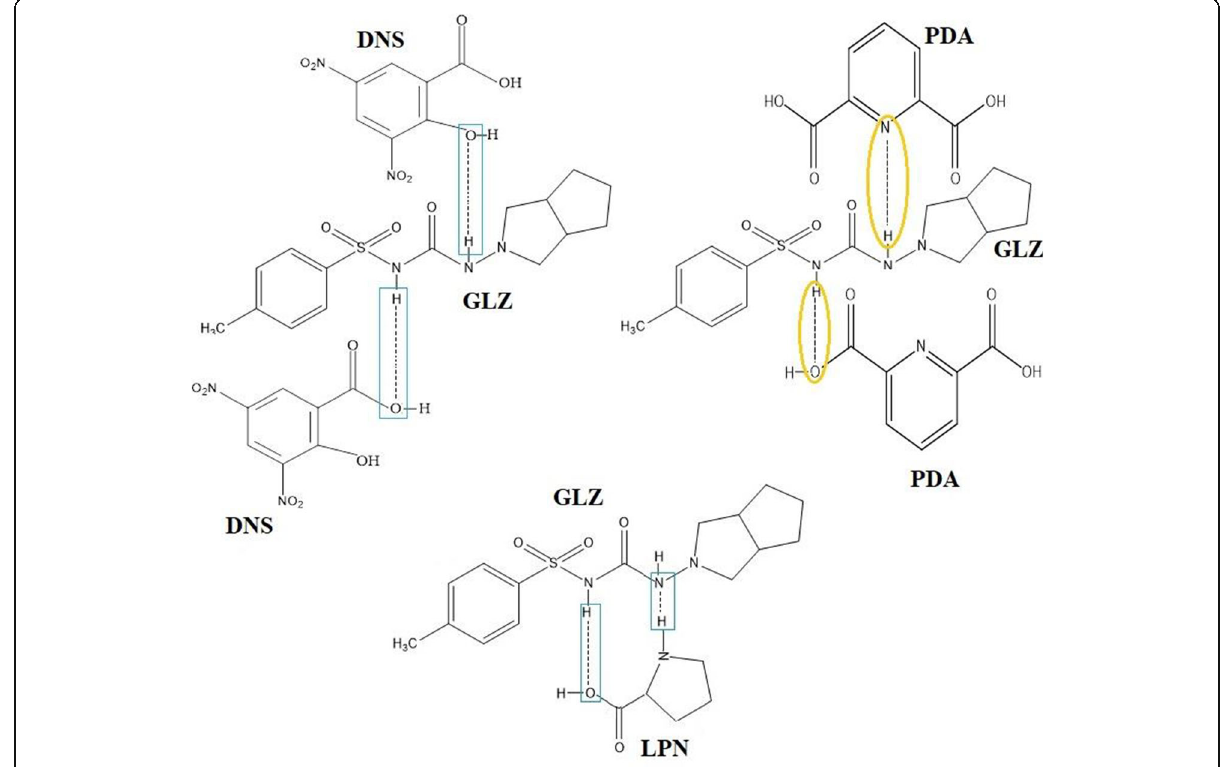
Fig. 2 Possible intermolecular interactions between GLZ – DNS, GLZ – PDA, and GLZ –